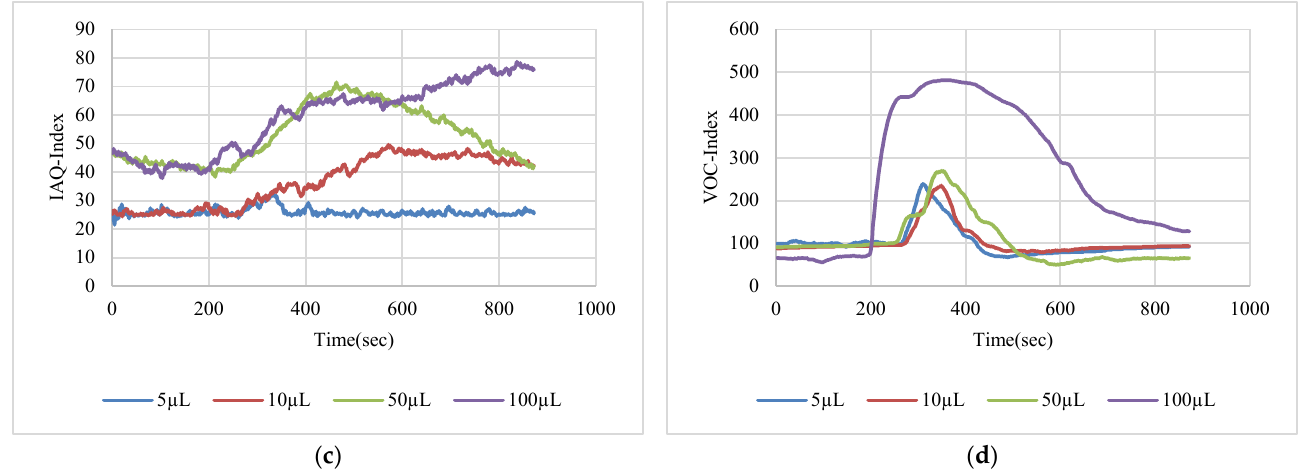
Figure 13. Test results for benzene: ( a ) BME688 40 cm, ( b ) SGP41 40 cm, ( c ) BME688 100 cm, ( d ) SGP41 100 cm.